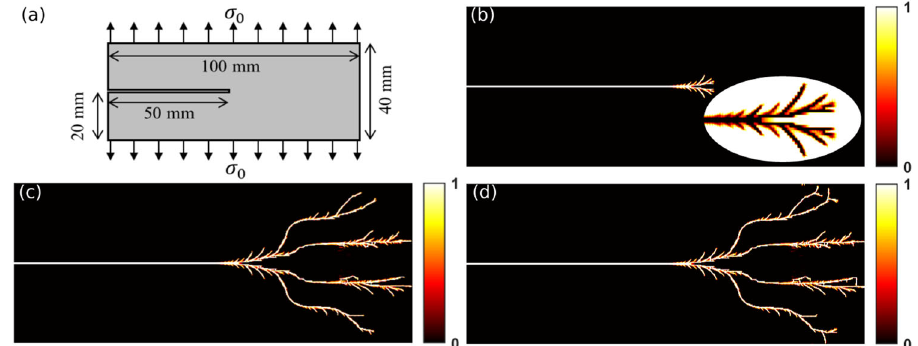
Fig. 2 Simulation of dynamic crack branching. a Schematic of the edge cracked block under tensile loading 33 . b Numerical simulation of the crack front near the onset of instability. The roughening of the crack surface is shown in the inset that provides a zoomed-in view of the crack face (color scheme inverted for better visibility). c , d Crack patterns obtained at the instants when the innermost branches and the outermost branches reach the boundaries of the